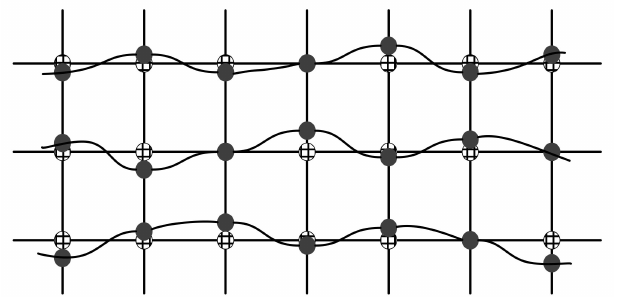
Figure 7. Schematic of the thermal vibrations of a lattice (plaid dot, the position of the atom before the vibration; filled dot, the position of the atom after the